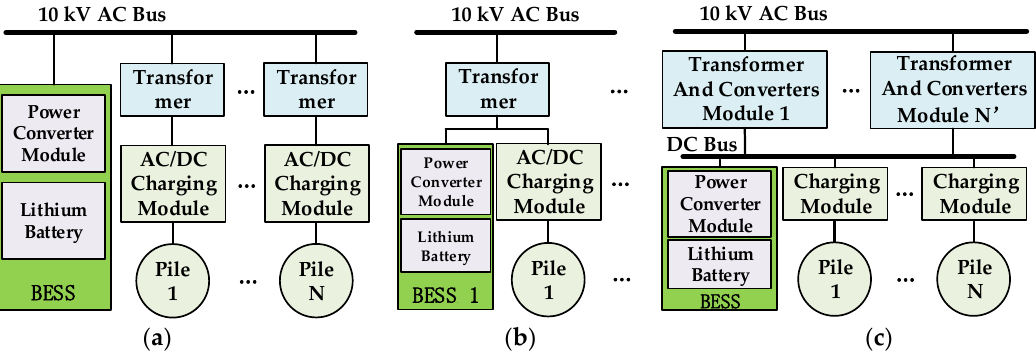
Figure 3. Three strategies of BESS configuration. ( a ) Scenario 1: Integrate the BESS with the AC bus; ( b ) Scenario 2: Integrate the BESS with each charging pile; ( c ) Scenario 3: Integrate the BESS with the DC bus.